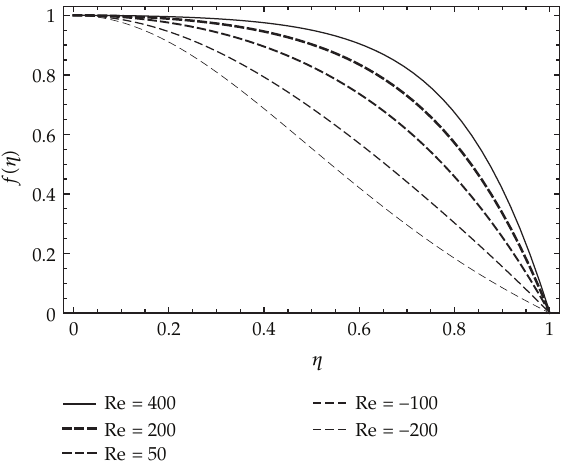
Figure 9: DTM solution for velocity in convergent channel for α (cid:8) − 2 . 5 ◦ and H (cid:8)